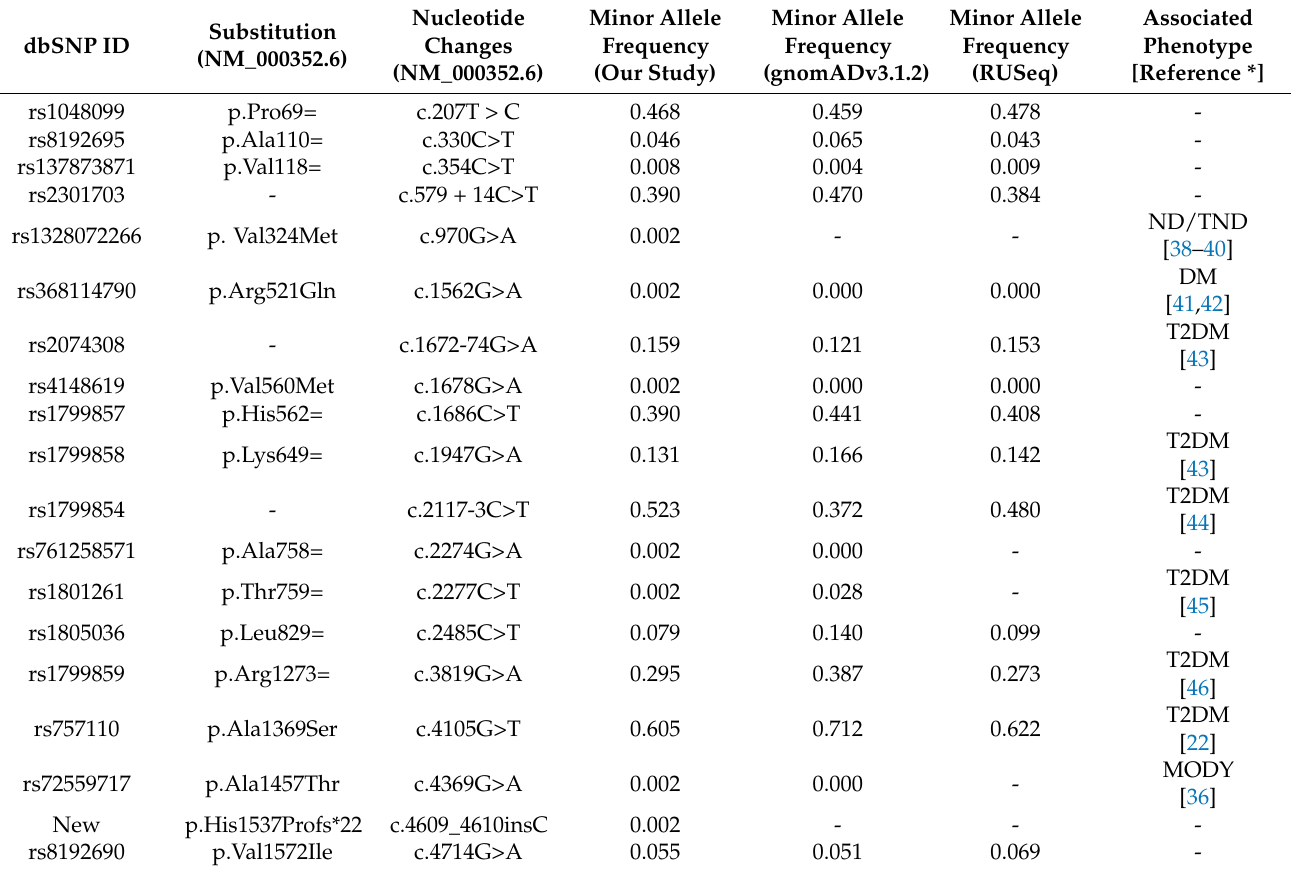
Table 2. The genetic variants in ABCC8 exons identified in our patients, their minor allele frequencies in our group of patients and according to the gnomAD and RUSeq databases, and associated phenotypes according to the literature